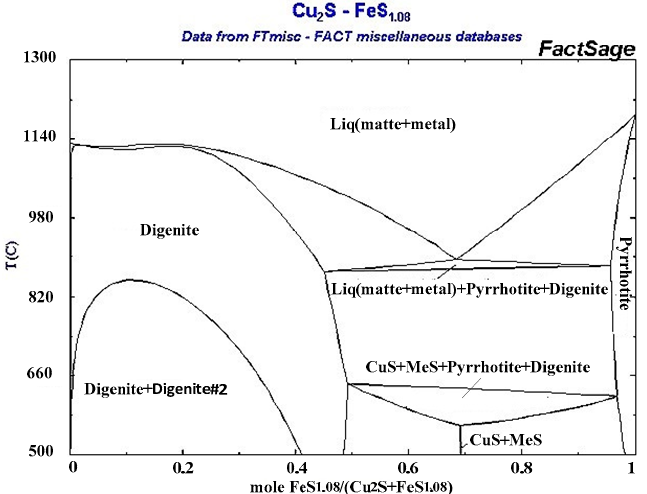
Figure 14. Cu 2 S ‐ FeS 1.08 binary phase diagram. Figure 14. Cu 2 S-FeS 1.08 binary phase